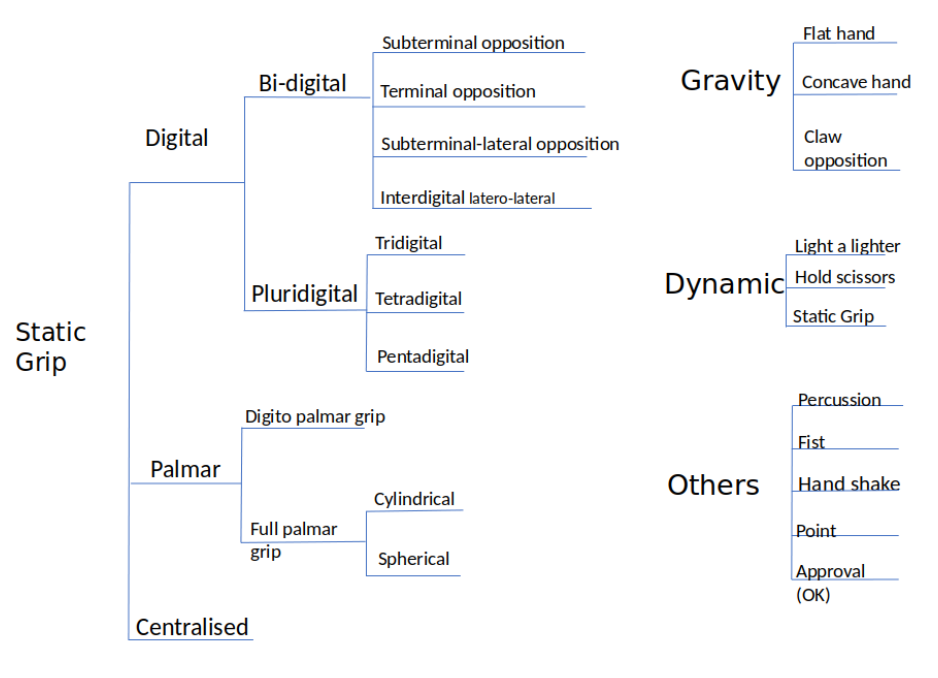
Figure 3. Human hand grip types